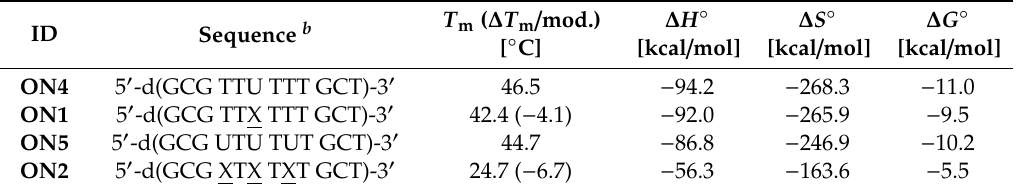
Table 3. T m values and thermodynamic parameters of duplexes formed between oligonucleotides and the complementary single-stranded RNA (ssRNA) a .